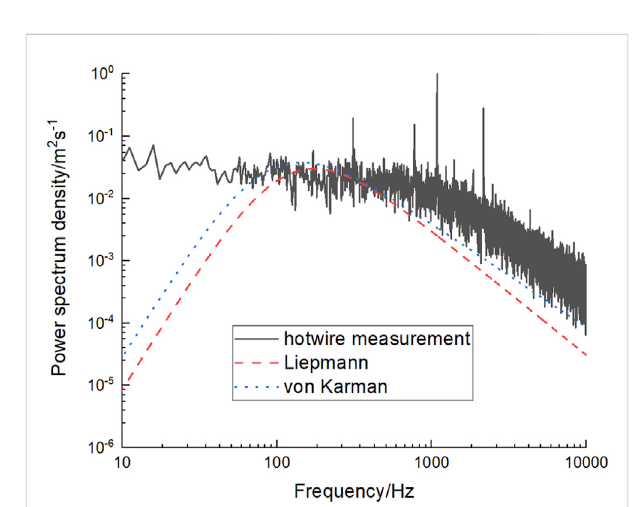
FIGURE 8 Power spectrum density under different models and hotwire